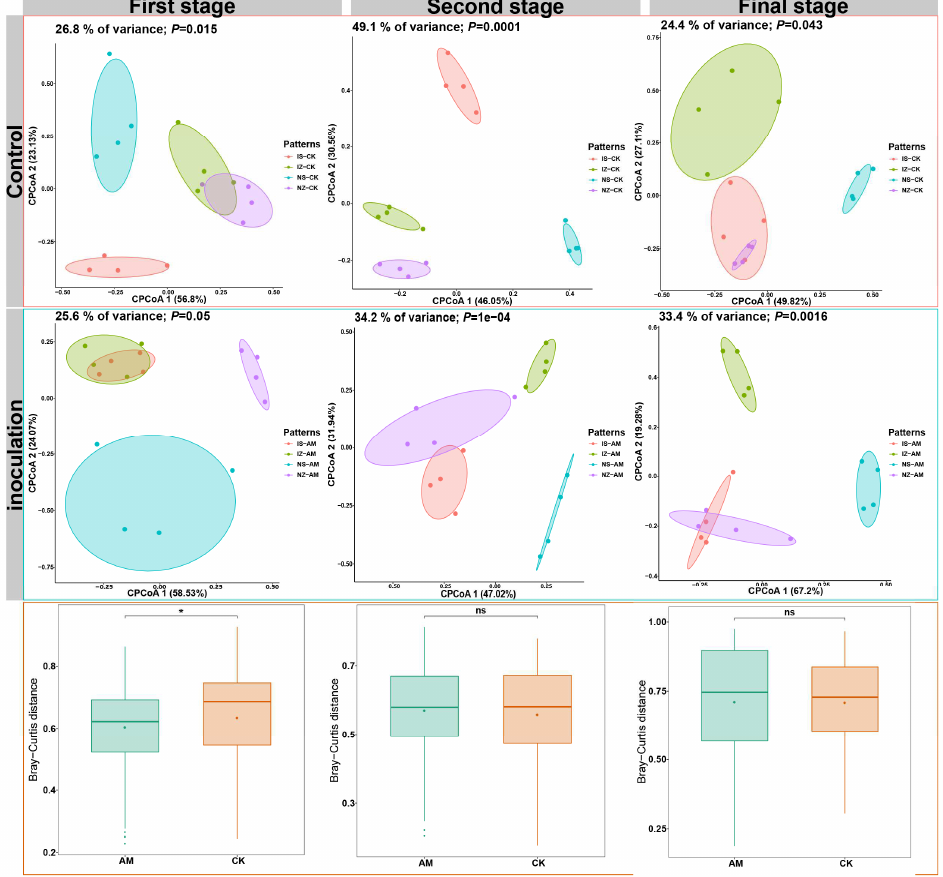
Figure 6. Principal coordinate analysis based on Bray–Curtis dissimilarities of AMF community compositions at different cropping patterns and plant growth stages.